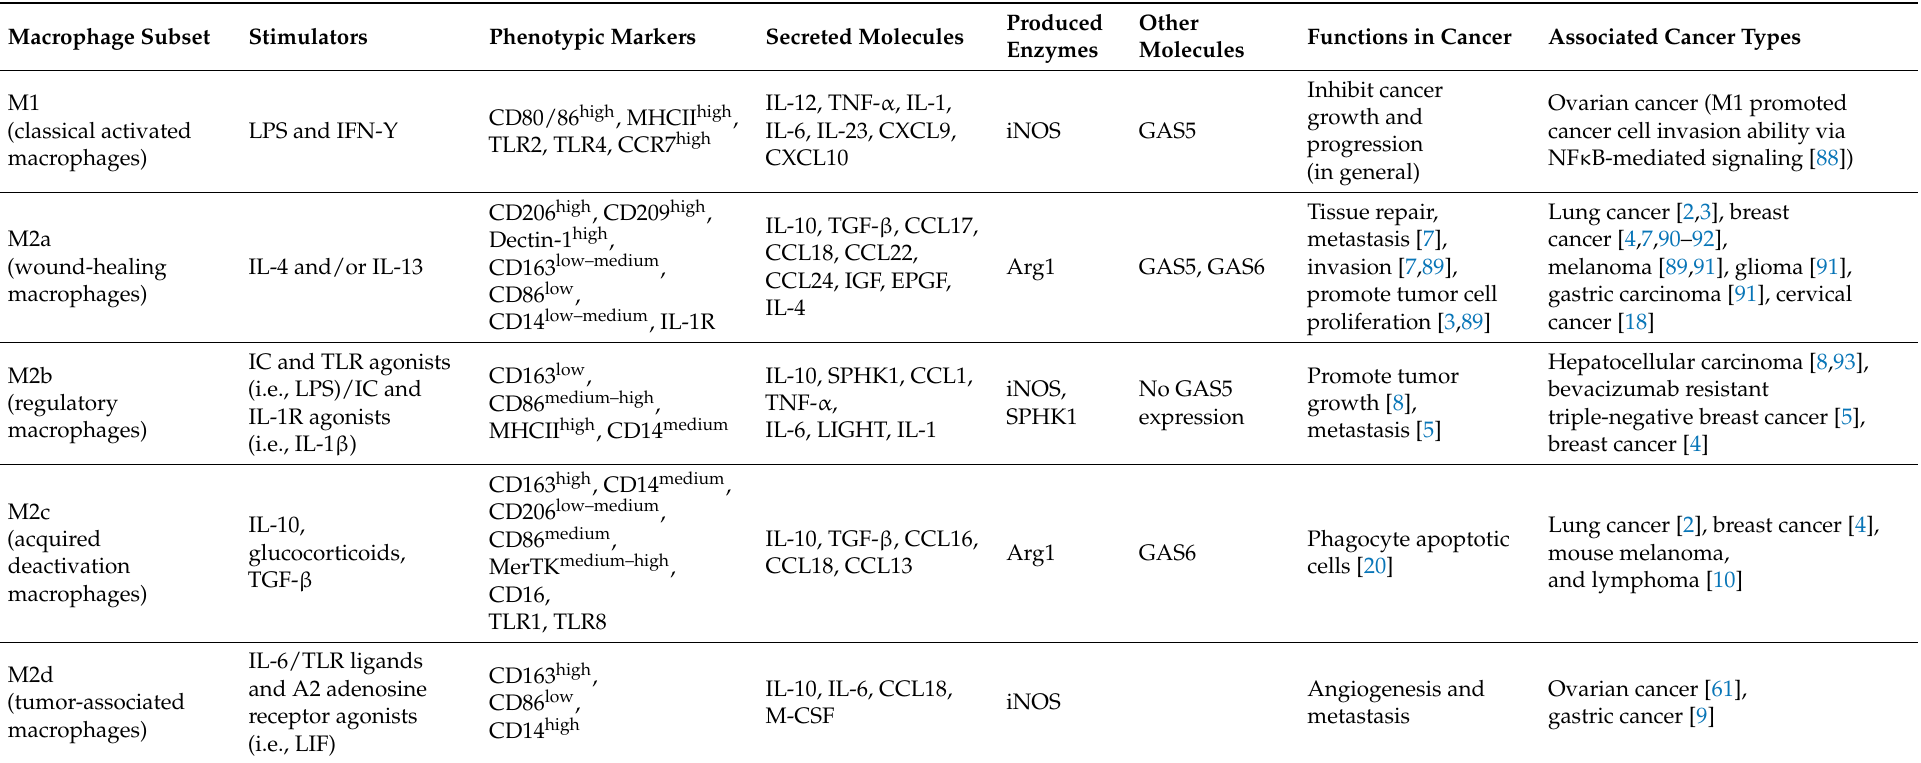
Table 1. Macrophage subsets and roles in